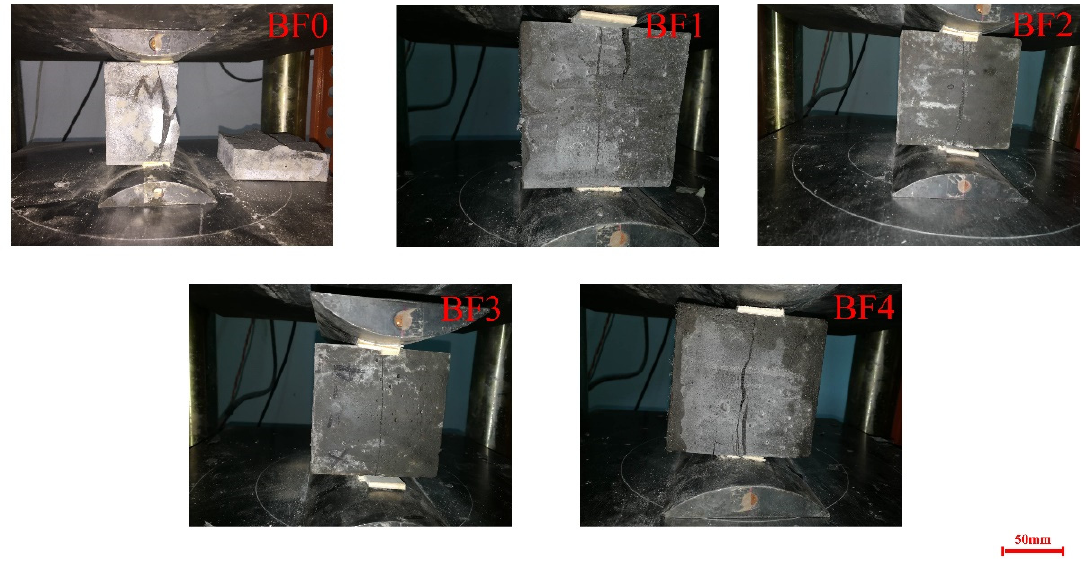
Figure 7. Splitting tensile strength failure mode.